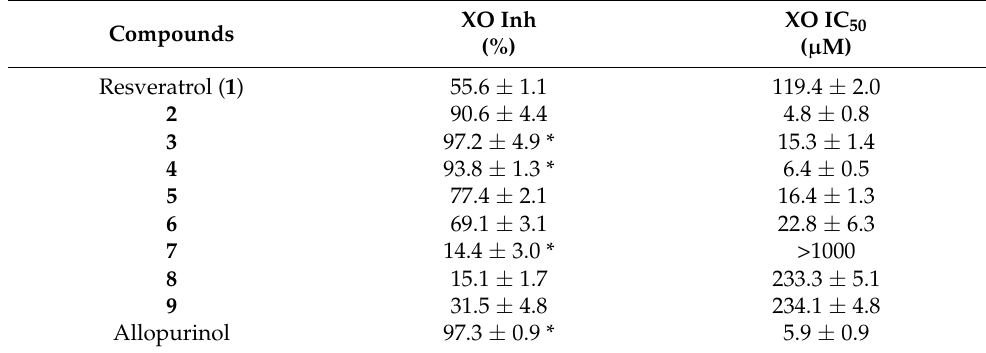
Table 2. XO inhibition percentage of compounds 1 – 9 at 100 µ M, and their IC 50 values. Results are expressed as mean ± SEM. *: p < 0.05 by one-way ANOVA using Dunnett’s post hoc test as compared to resveratrol, n = 4; due to the large differences, statistical significance was not evaluated for the IC 50 values. XO Inh Compounds